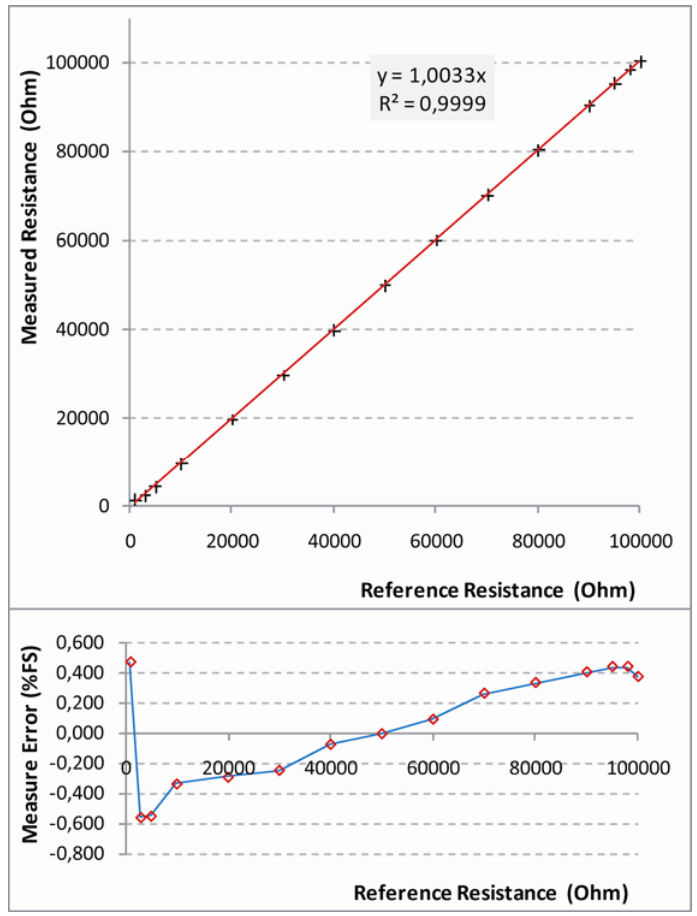
Figure 18. Results of characterization test carried out on UISI Resistive Sensor configuration. Top graph show the measured resistance vs. the reference resistance; Bottom graph shows the corresponding error in Full Scale (FS)